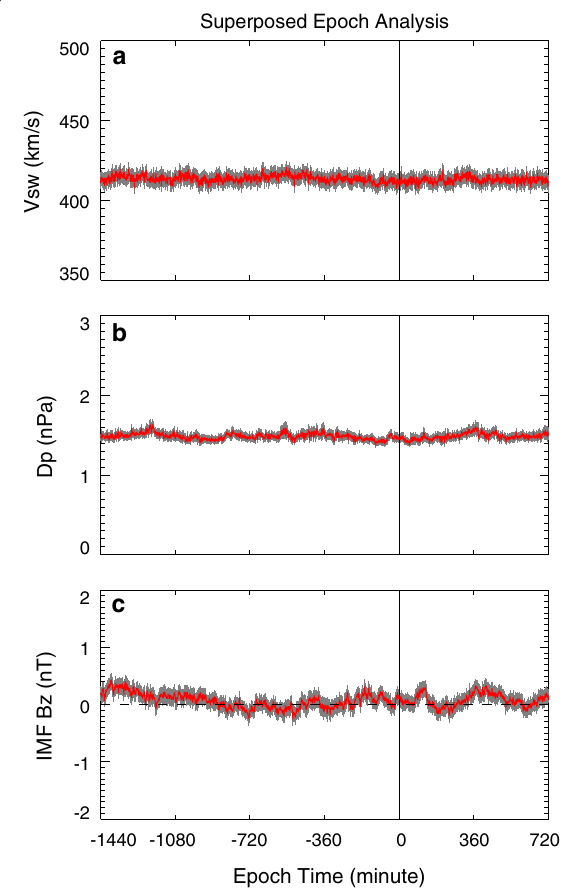
Fig. 2 Variations of solar wind parameters in reference to times of the FS3 anomalies. a – c Superposed epoch analyses on solar wind speed, dynamic pressure, and IMF Bz , respectively. The vertical line indicates zero epoch time, which was set to the times of the FS3 anomalies. The red curves display the variations in these three parameters. The gray areas above and below a red curve indicate standard errors